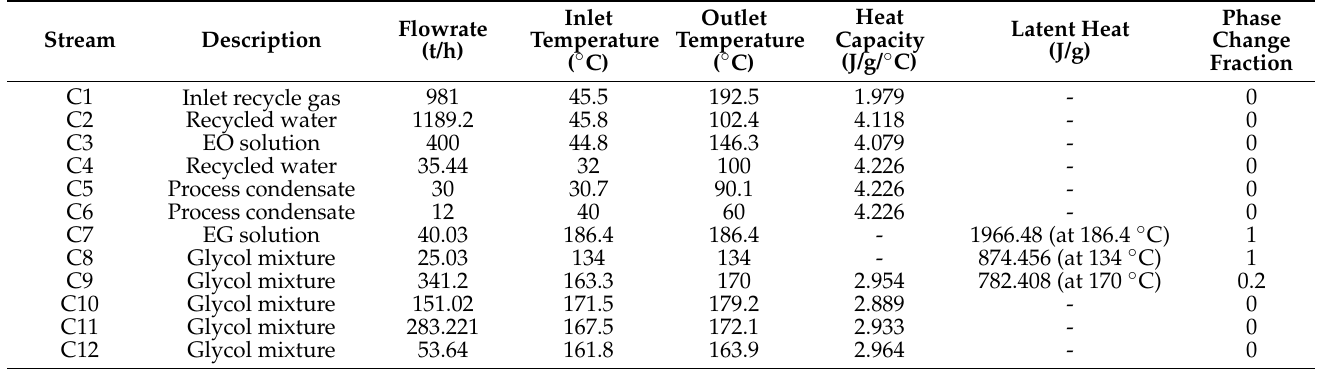
Table 2. Cold process stream